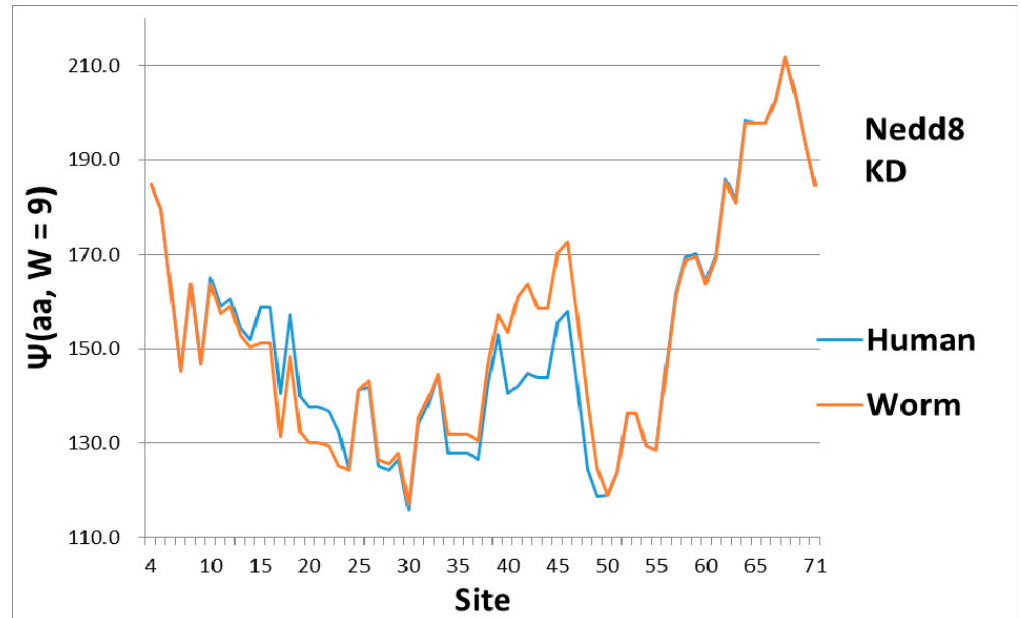
Figure 3. In the evolution of Nedd8 from worm to human, most of the changes appear to be first order (KD scale) and are concentrated in softening the central pivot. This contrasts strongly with distributed smoothing of ubiquitin in Figure 1. Note also that the C terminal here is much more hydrophobic than the N terminal, whereas the two ends are nearly equally hydrophobic (level) in Ub (Figure 1).